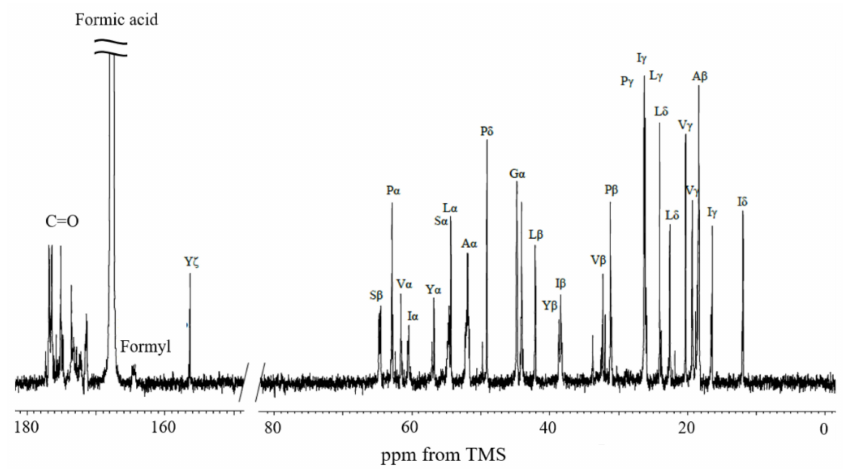
Figure 2. 13 C solution NMR spectrum of RSSP(VLI) sample in formic acid after dissolving it for 15 h together with the peak assignments.